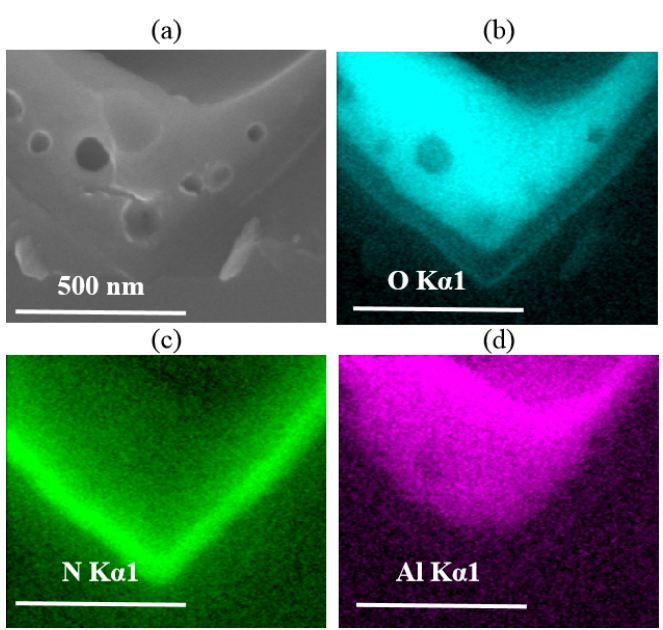
Figure 8. ( a ) Si/metallization interface SEM images of Cell 2; ( b – d ) Energy dispersive spectroscopy (EDS) mapping images obtained at Si/metallization contact area shown in ( a ). Different element such as O, N, Al are identified as different colors.